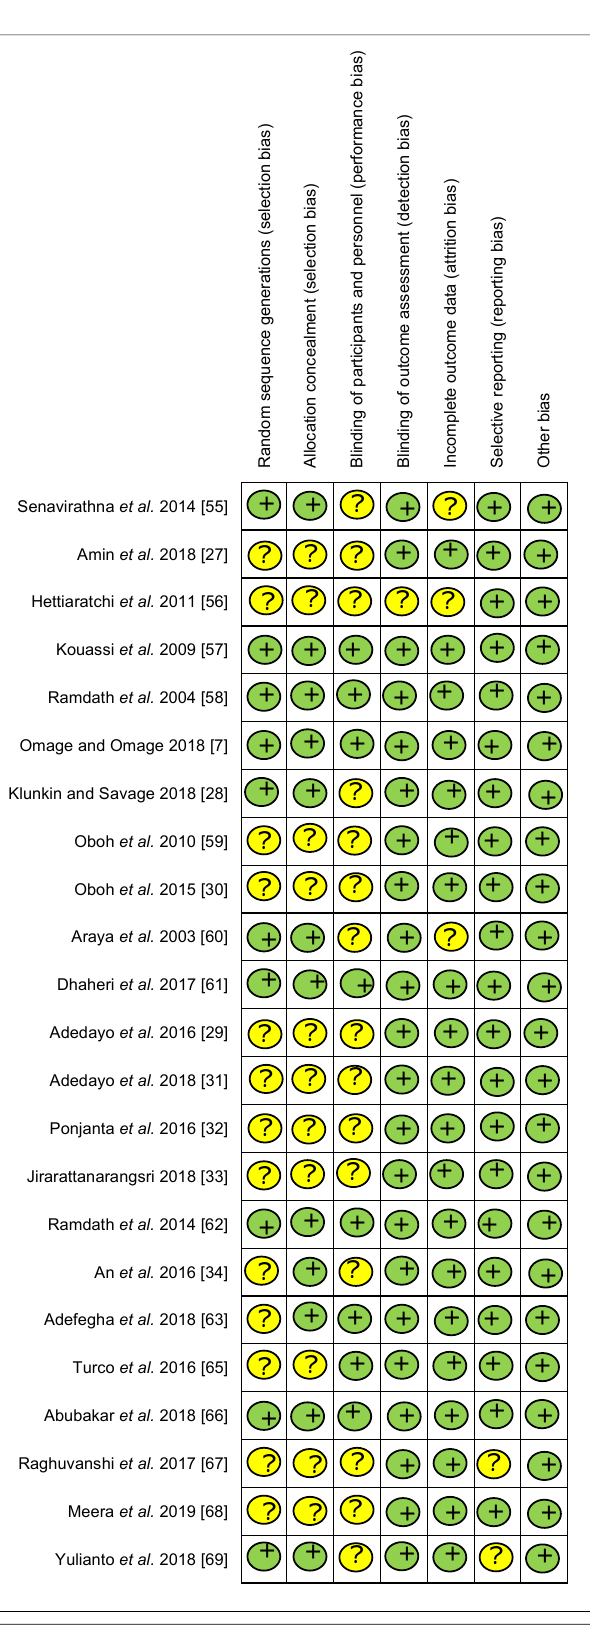
Figure 2. The result of the risk of bias assessment: each risk of bias item for the included studies (green means low risk of bias, yellow means unclear risk of bias, red means high risk of bias).